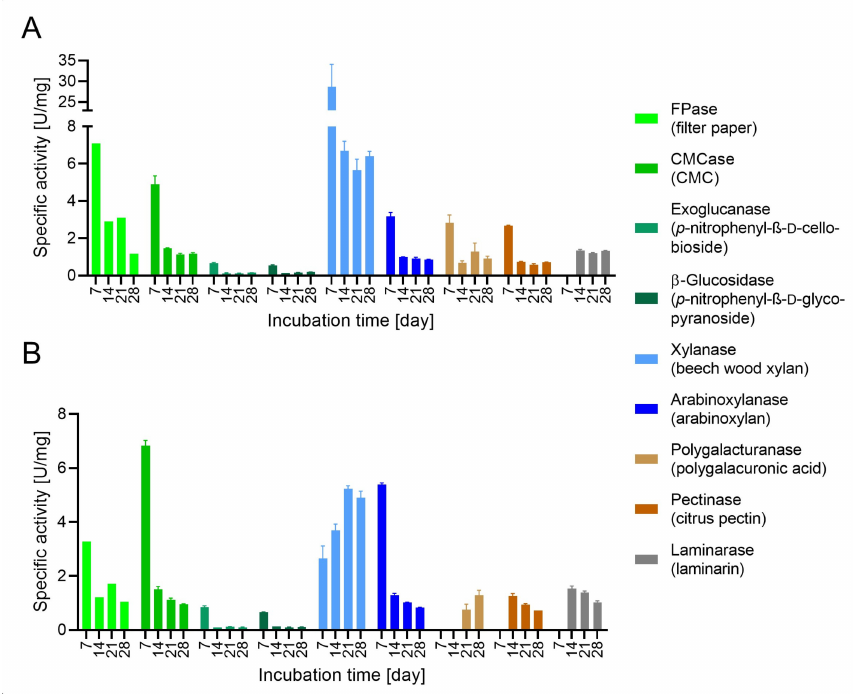
Figure 4. Time-course analysis of the enzymatic activities of FW57 growing on ( A ) sugarcane bagasse (SCB) and ( B ) maize leaves